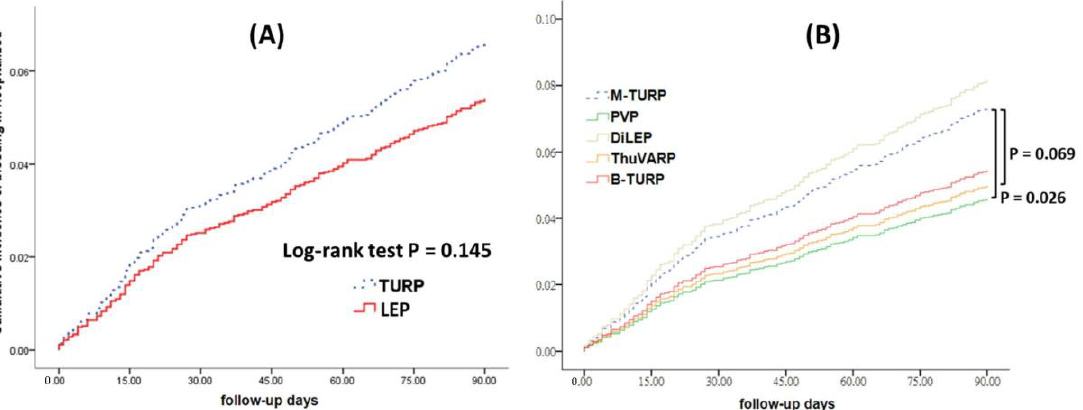
Figure 3. ( A ) Cumulative incidence of emergency room (ER) visits with postoperative bleeding post TURP and laser surgery. ( B ) Cumulative incidence of ER visits due to postoperative bleeding post different surgery groups. Abbreviations: M-TURP, Monopolar transurethral resection of the prostate; B-TURP, Bipolar transurethral resection of the prostate; PVP, GreenLight Photo vaporization of the prostate; ThuVARP, Thulium Laser Vaporesection of the Prostate; HoLEP, Holmium laser enucleation of the prostate; DiLEP, Diode laser (980 nm) enucleation of the Prostate.